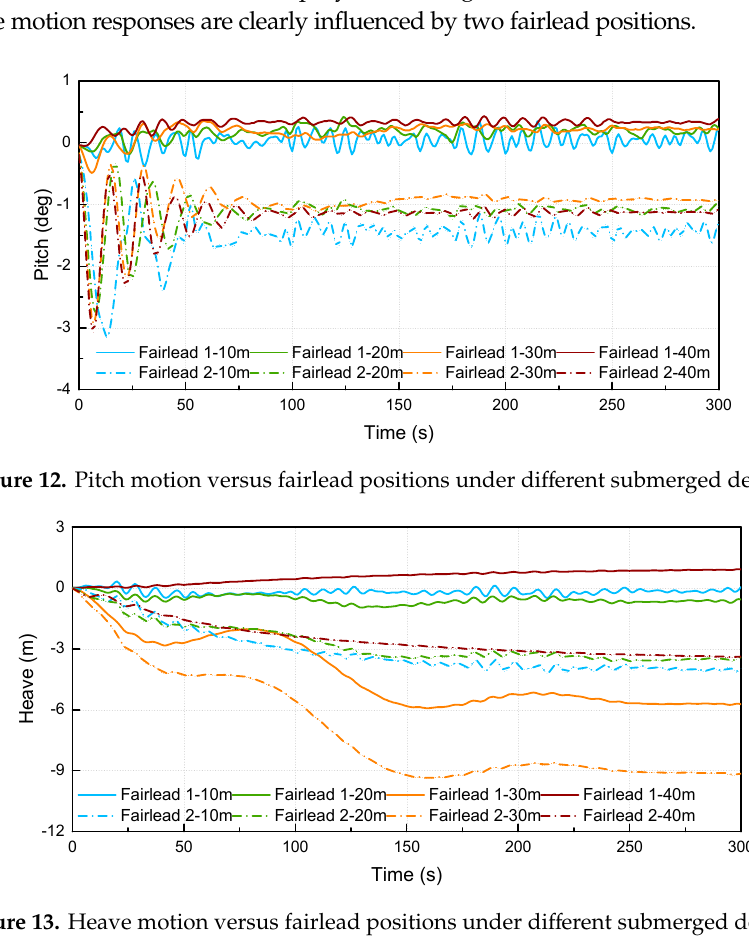
Figure 13. Heave motion versus fairlead positions under different submerged depths.